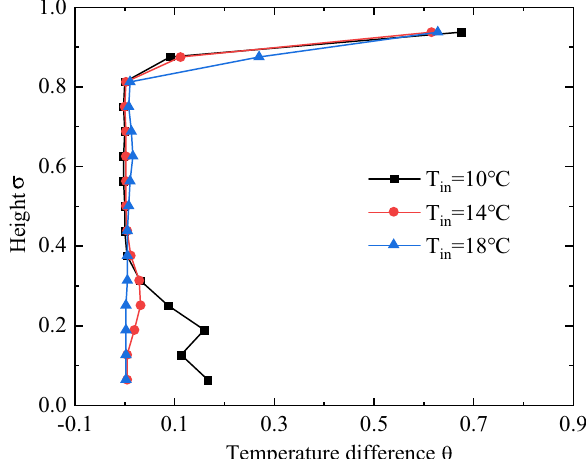
Fig. 16 Temperature change of L1 when Re is 2633 and Fo is 0.9 in forward